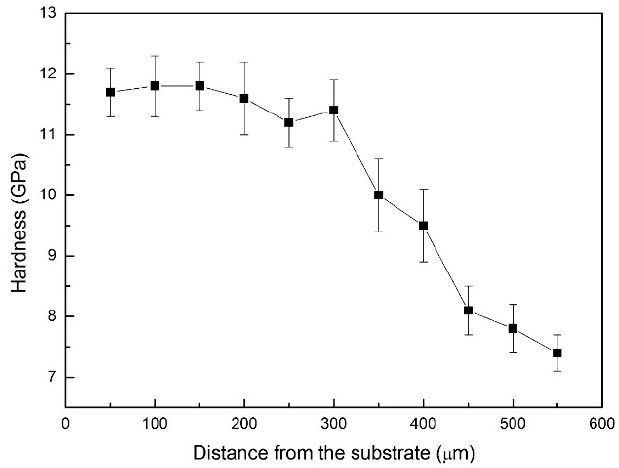
Figure 4. Hardness variation along the coating thickness.